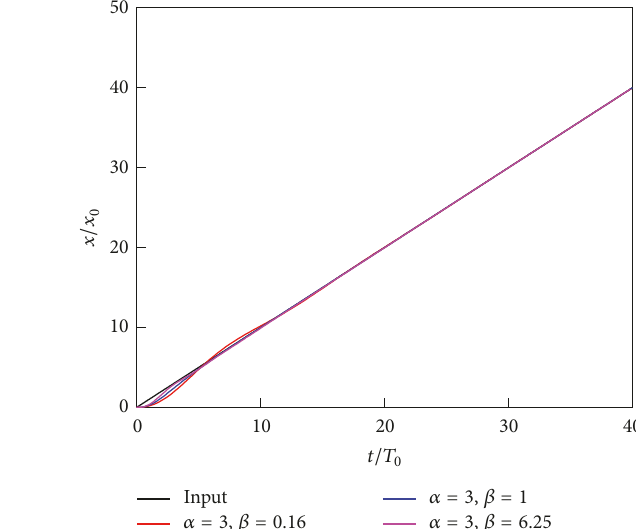
Figure 25: Response in the time domain ( 𝛼 = 1.5, 𝛽 = 0.16, 1, 6.25 ).